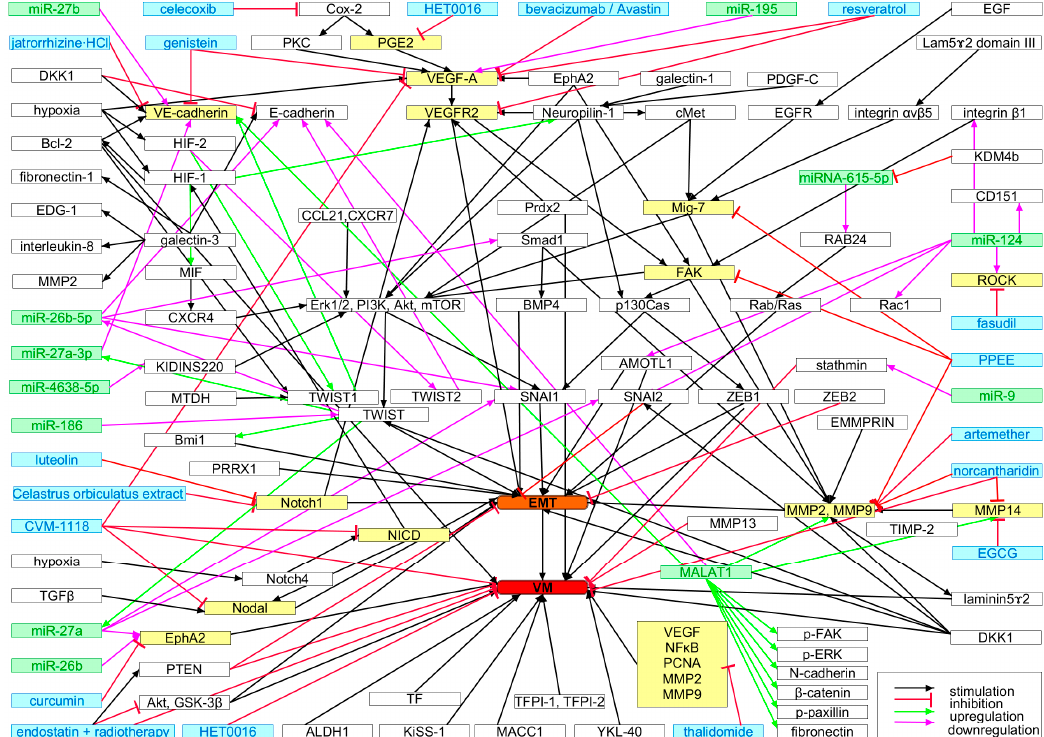
Figure 5. Molecular phenotype-defining signaling pathways in vasculogenic mimicry (VM). Signaling molecules that have been targeted to inhibit VM are highlighted in yellow and targeting compounds are marked in blue. Regulatory miRNAs are labeled green. EMT (highlighted in orange), which is pivotal for VM, and VM (highlighted in red) are the focal points in which all these signaling pathways converge. For details and references, see text.